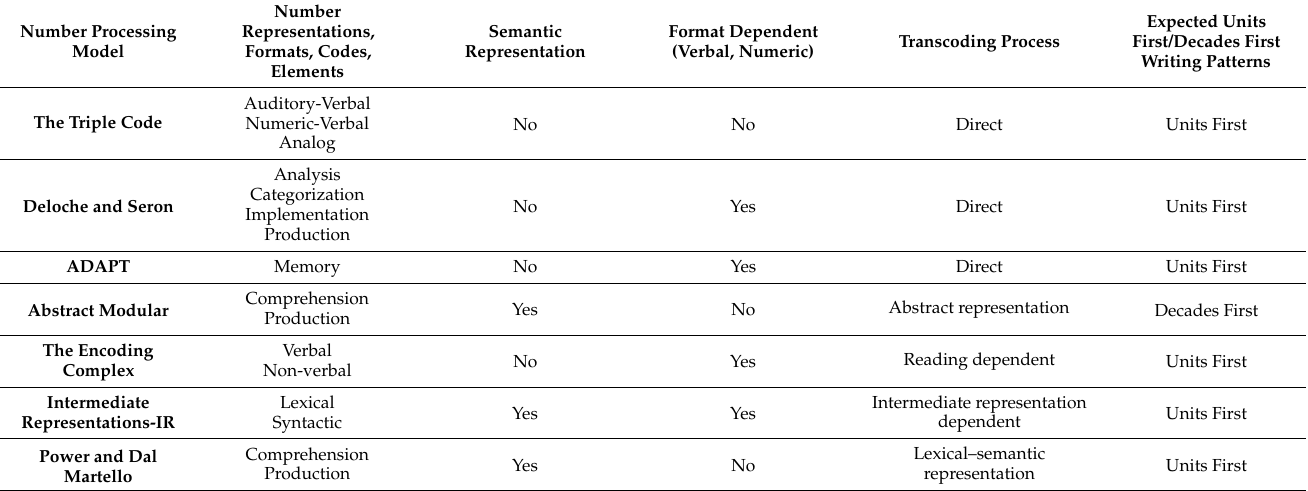
Table 1. Summary of number processing models and their predicted units/decades first writing patterns in two-digit numbers transcoding to